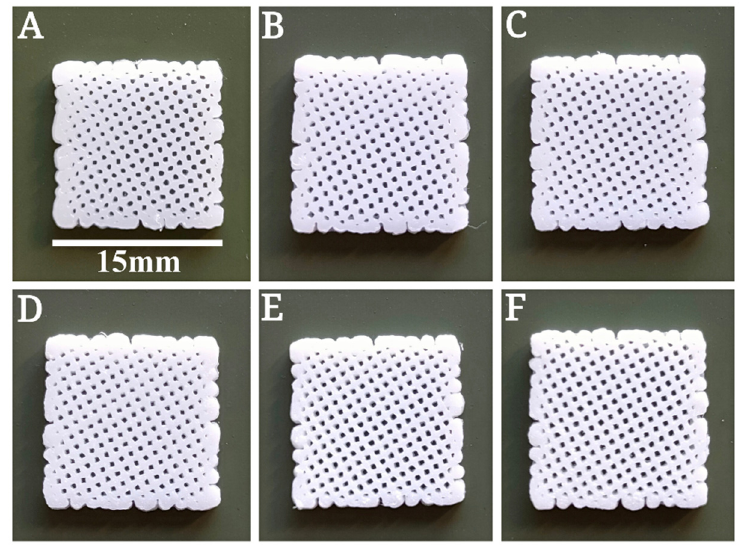
Figure 2. Examples of printed six groups’ scaffolds (15 × 15 × 2 mm). ( A ) PCL. ( B ) PCL + 5% HA. ( C ) PCL + 10% HA. ( D ) PCL + 15% HA. ( E ) PCL + 20% HA. ( F ) PCL + 25% HA.